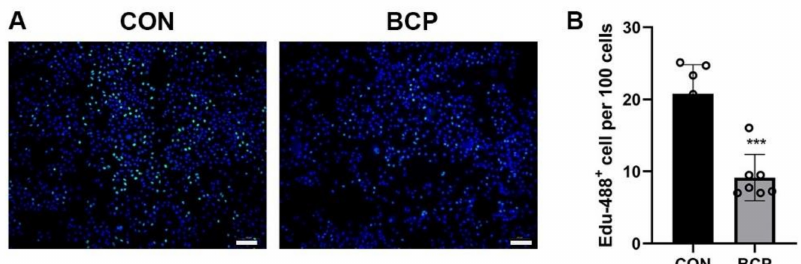
Figure 6. Proliferation ability of L929 fibroblasts cultured with BCP particles. ( A ) Representative images of Edu staining and ( B ) Semi-quantitative results showed proliferation of L929 fibroblasts was inhibited by BCP ceramics and the number of proliferative fibroblasts labelled by green fluorescence in BCP group was reduced to half of that in control group. Scale bar: 120 µ m. *** indicated p < 0.001.